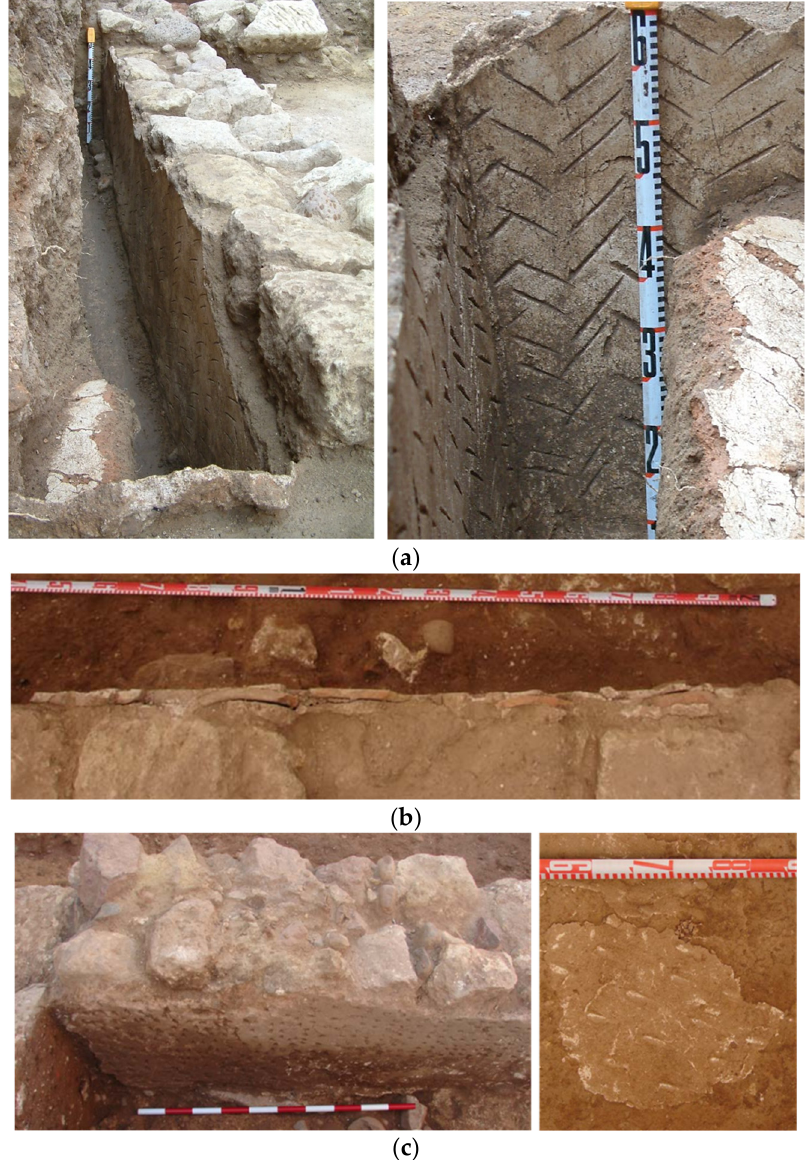
Figure 3. Double layer coatings in the Córdoba of the twelfth century: ( a ) Ollerías Avenue (Molina Exp ó sito 2004); ( b , c ) America Avenue (Valdivieso 2007; Molina Exp ó sito